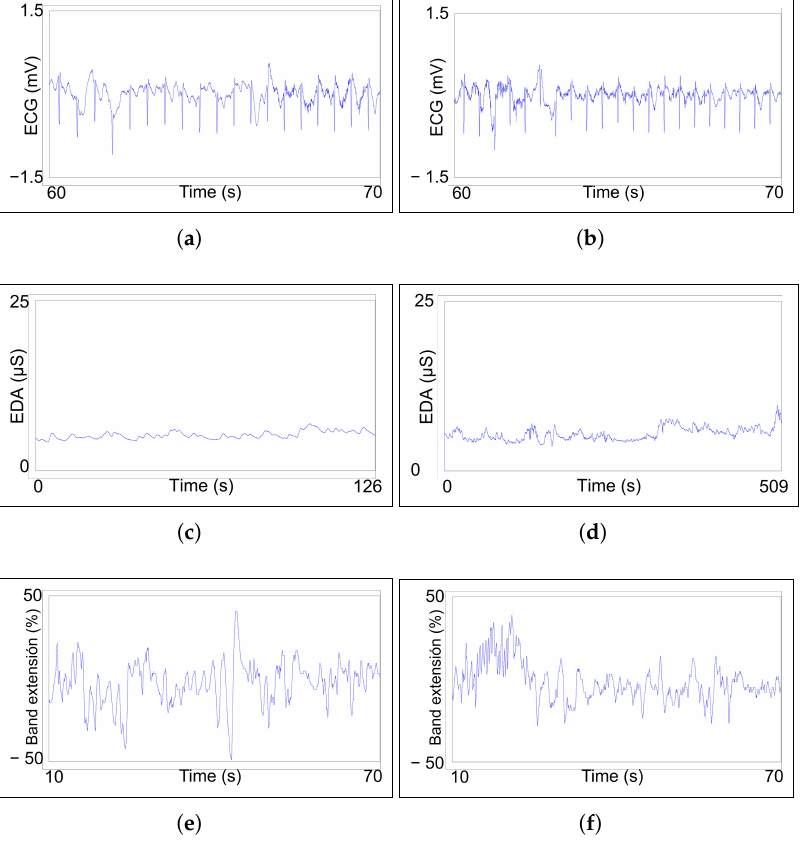
Figure 9. Bio-signals recorded during a real-time monitoring exercise. On the left, recordings corresponding to the first measured interval (126 s). On the right, recordings of the second measured interval (509 s): ( a , b ) 10 s sample of ECG recording to show ECG signal intervals; ( c , d ) complete EDA recording; ( e , f ) one-minute sample of PZT recording.